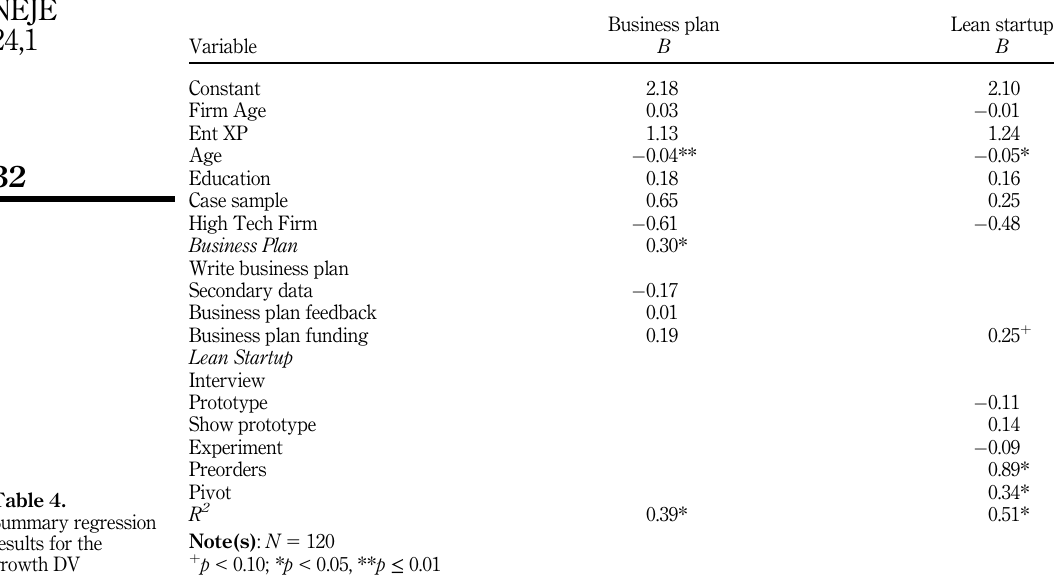
Table 4. Summary regression results for the growth DV